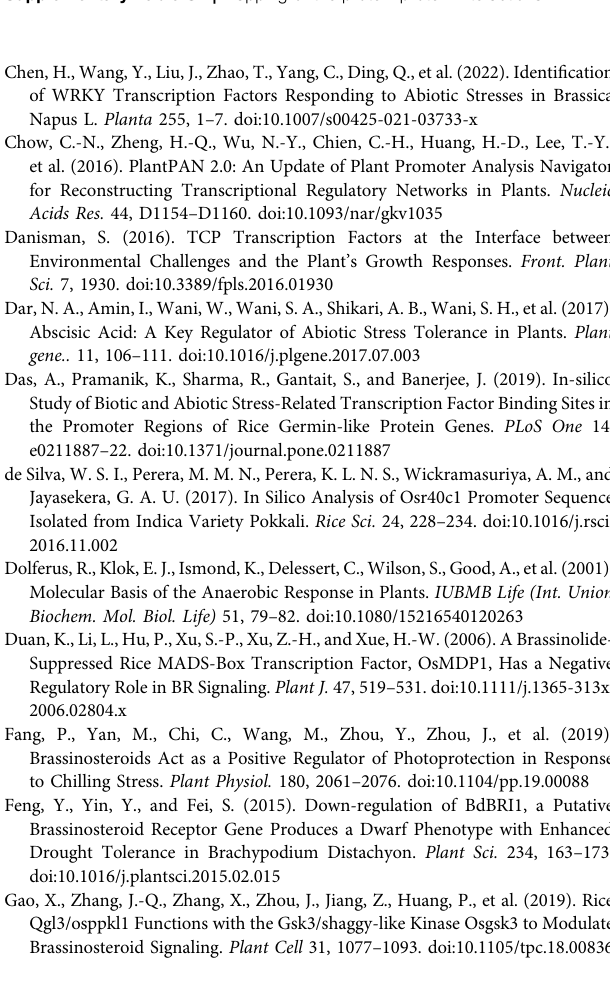
Supplementary Table S3 | Common transcription factor binding sites (TFbs) present in promoters of the BR signaling genes in rice. Supplementary Table S4 | Detailed information about the cis elements which are present within promoters of the 39 BR signaling genes in rice. Supplementary Table S5 | The most common cis element presents in promoters of the BR signaling genes in rice. Supplementary Table S6 | Detailed information about the conserved motifs identi fi ed within promoters of the BR signaling genes in rice. Supplementary Table S7 | Mapping of the protein-protein